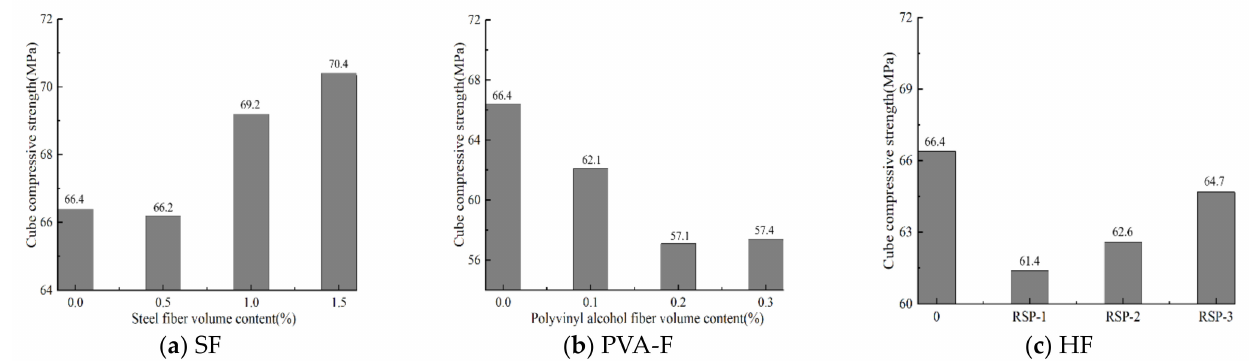
Figure 10. Cube compressive strength of fibre-reinforced recycled